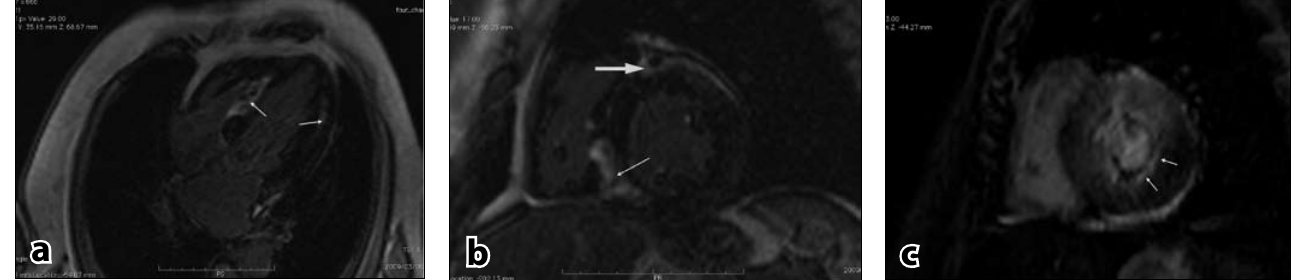
Fig. 8. Delayed enhancement CMR in non-ischaemic cardiomyopathies. (8a.) Four-chamber orientation showing multifocal enhancement (arrows) in a patient with cardiac sarcoidosis. (8b.) Short-axis orientation in cardiac sarcoidosis. The distribution of enhancement (subepicardial (block arrow) and at the LV-RV junction (arrow)) is typical. (8c.) Short axis image in cardiac amyloidosis. Note the inhomogeneous LV nulling indicating diffuse infiltration with typical distribution (subendocardial not limited to vascular territories) enhancement (arrows).